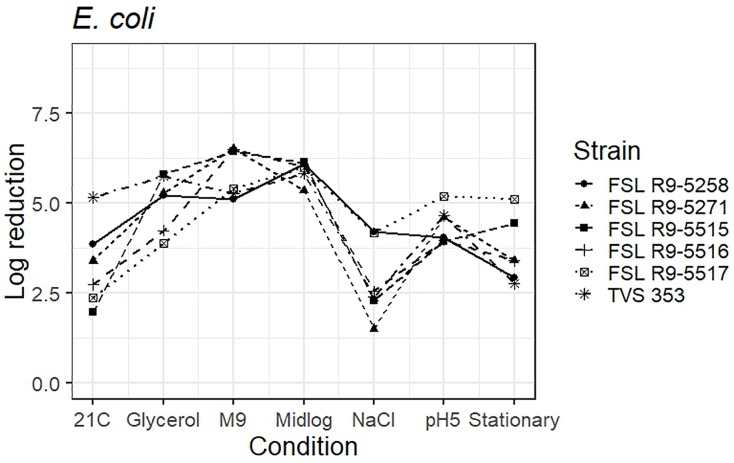
Average log reduction of five STEC strains and one surrogate (E. coli strain, TVS 353) when pre-grown under different conditions prior to exposure to 40 ppm PAA for 45 s. Pre-growth conditions are shown on the X-axis and include pre-growth (i) at 21°C (21C), (ii) under reduced water activity (Glycerol), (iii) in minimal medium (M9), (iv) to mid-log phase (Midlog), (v) in 4.5% additional NaCl (NaCl), (vi) at pH 5.0 (pH5) and (vii) to stationary phase (Stationary). When calculating log reduction, values with count zero post-sanitizer treatment were substituted with the detection limit (e.g., 100 CFU/mL). Data represent averages from three trials; the standard deviation of the three trials and number of trials with values below detection limit after PAA exposure are listed in Supplementary Table 6.